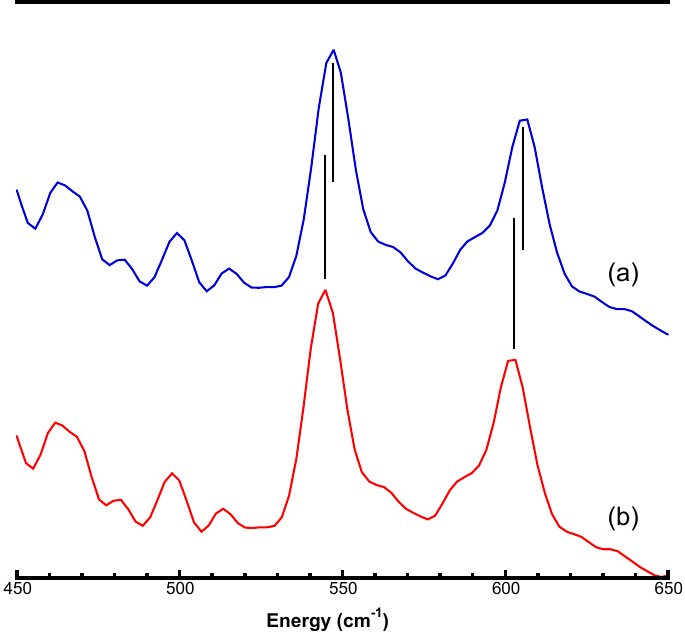
Figure 6. The FeCO feature [in DvM F NiFe hydrogenase NRVS] in the lower energy side of the 30 s/p to 1 s/p timing changing point: ( a ) the NRVS spectrum calibrated with the traditional calibration procedure; and ( b ) the NRVS spectrum re-calibrated with the time-scaled calibration procedure (2).